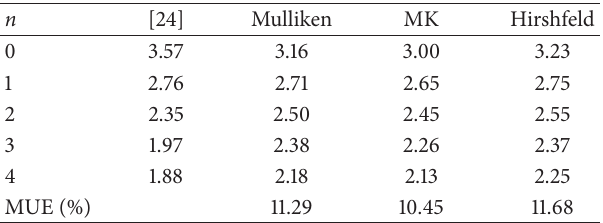
Table 1: Calculated ion mobilities of water clusters (H 3 O + ) ( H 2 O ) 𝑛 typically found in the RIP (all in cm 2 V −1 s −1 ). The mean unsigned error (MUE) is calculated in relation to the values obtained by